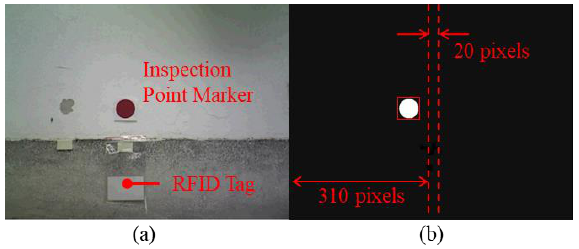
Figure 6. ( a ) An inspection point marker with radio frequency identification (RFID) tag and ( b ) the corresponding binarized results from SVS.